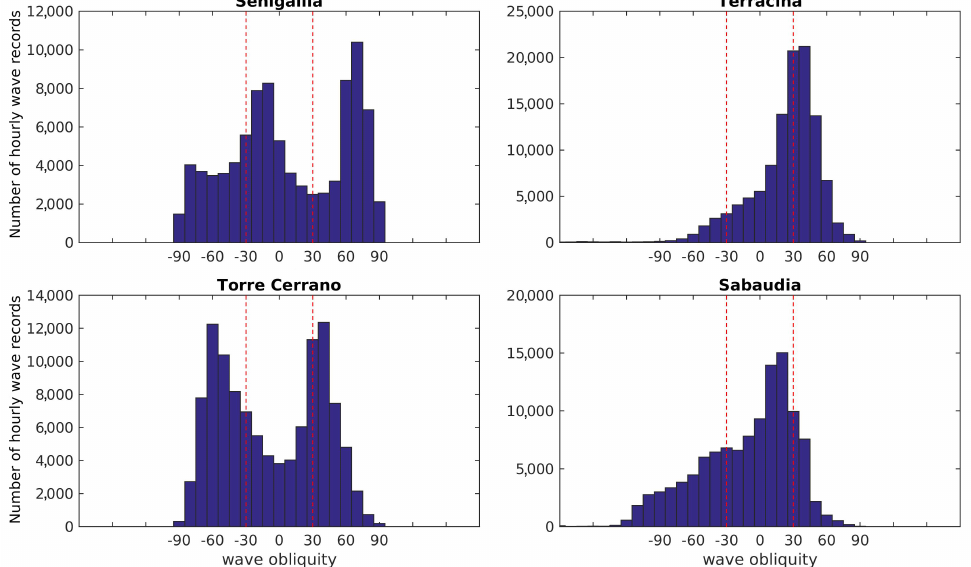
Figure 3. Distribution of wave obliquity at Senigallia, Terracina, Torre del Cerrano and Sabaudia. The red dashed lines demarcate the ± 30 ◦ interval of wave incidence with respect to the shore normal. In the y -axis the number of hourly wave records coming from a given direction interval throughout the total observation period is